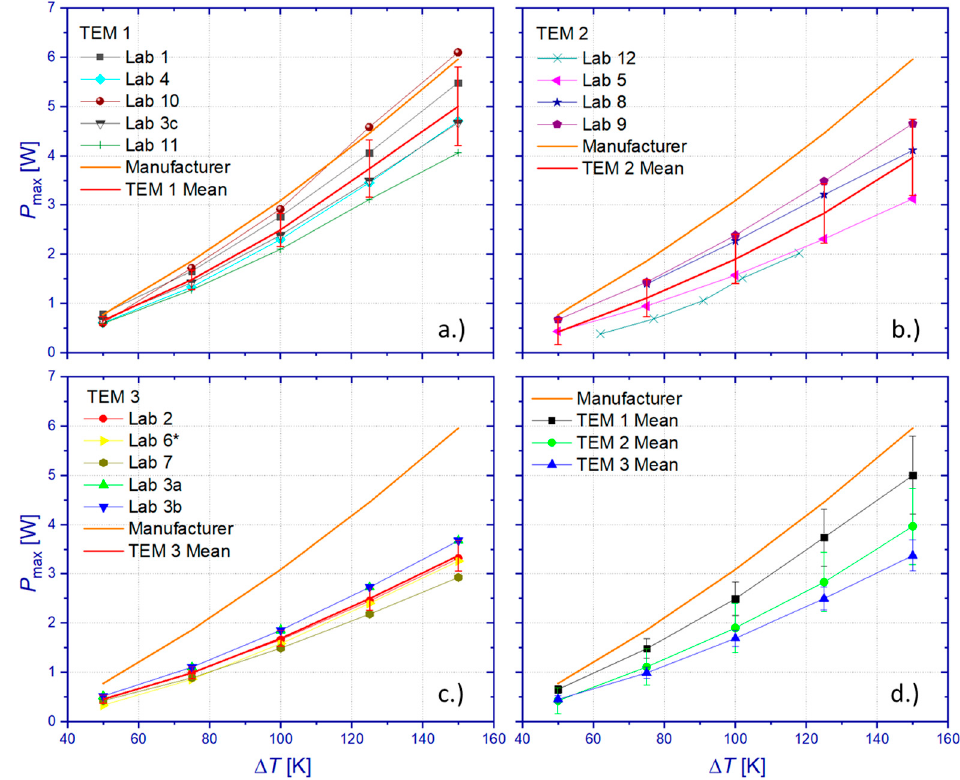
Figure 9. RR results for maximum power output P max in dependence on the temperature difference Δ T . The results are shown separately for measurements on TEM1 ( a ), TEM2 ( b ), and TEM3 ( c ). Mean values and their corresponding standard deviation, which is displayed as error bars, have been calculated from all data sets of each TEM. Manufacturer specifications are shown for comparison with the mean values of the tested TEMs ( d ).